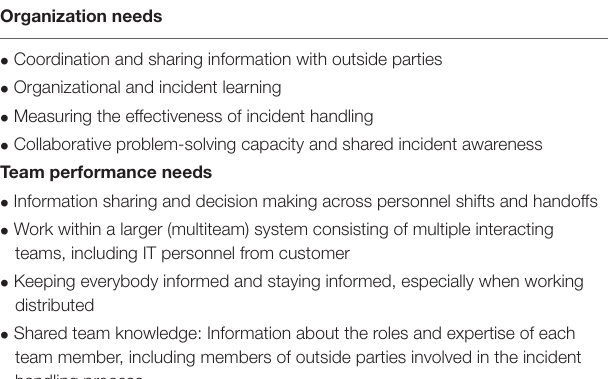
TABLE 1 | Overview of needs and wants of Incident Response